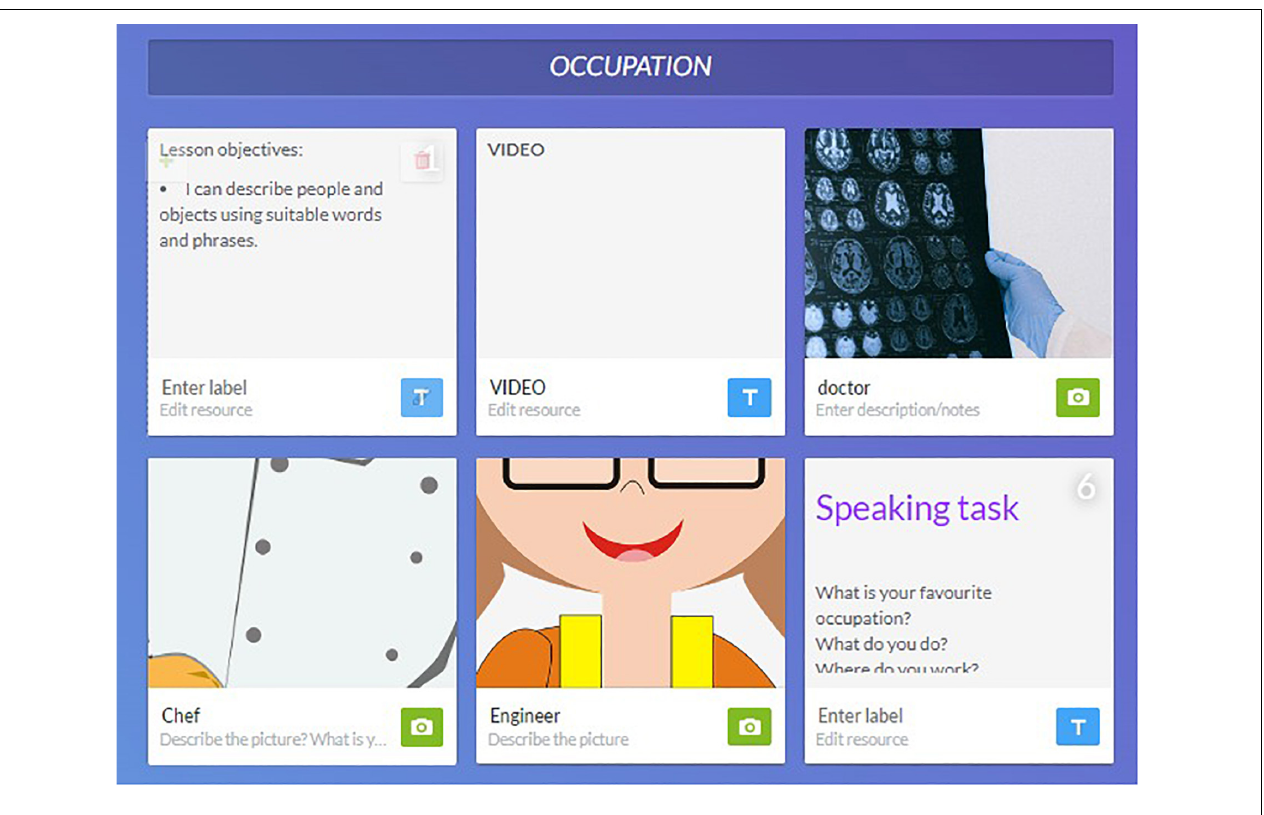
FIGURE 1 | A complete Blendspace